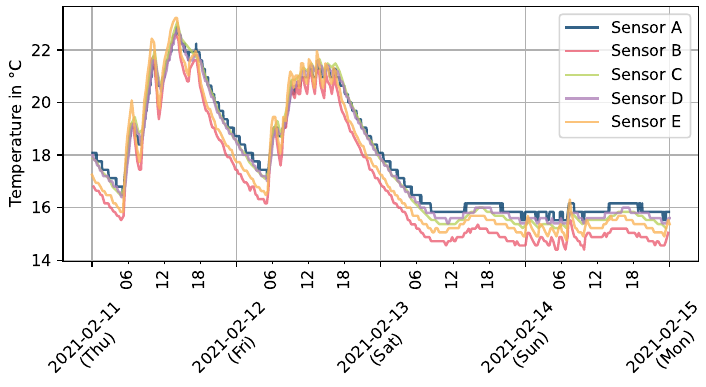
Figure 8. Comparison of temperature measurements with different EnOcean sensors in the same